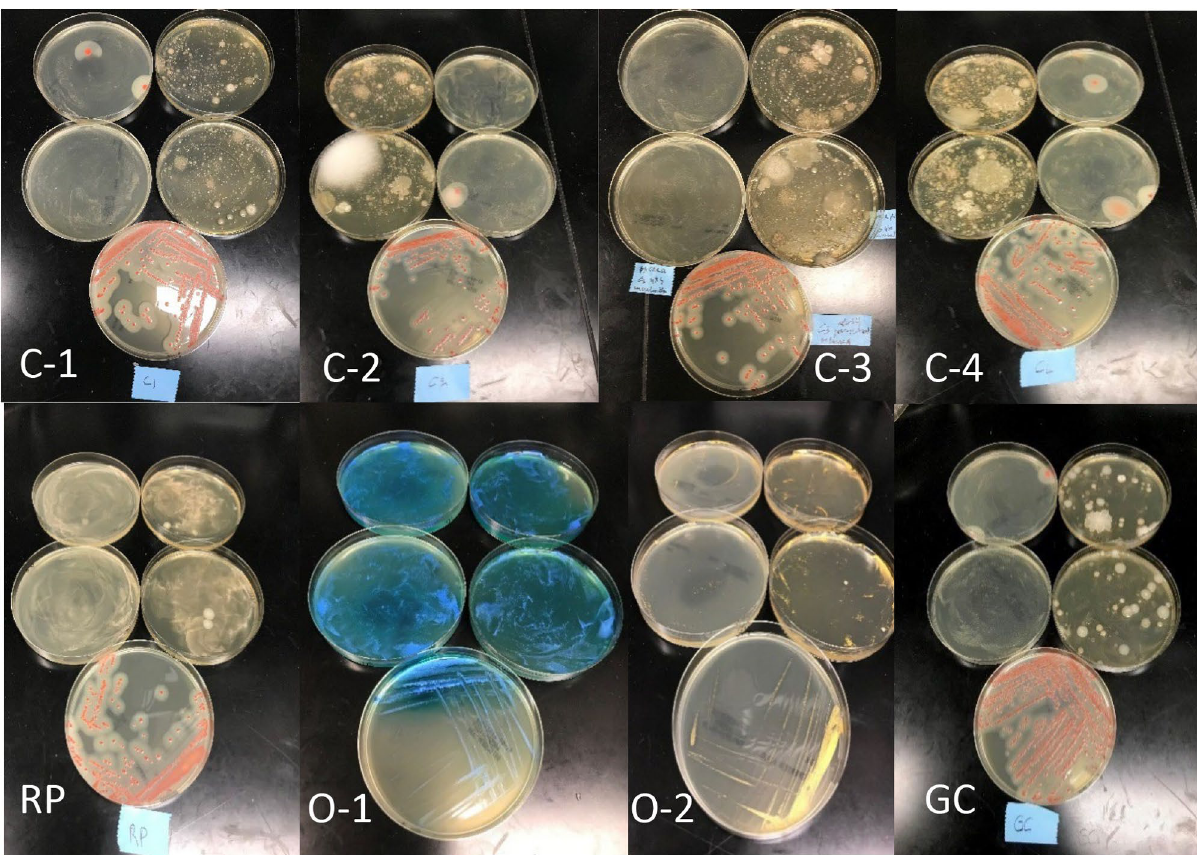
Figure 4. Detection of B. cereus on BACARA plates in powder-type cosmetics. 100 μl of the initial dilution of products (C1, C-2, C-3, C-4, C-5, RP, O-1, 0–2, and GC) spread on MLA and BACARA plates in duplicate (top 4 plates in each image), and a loop streaked on a plate of BACARA after 24 h enrichment (fifth plate at the bottom of each set). ( A ) positive ( B ). cereus result on BACARA shows as orange colonies with a white